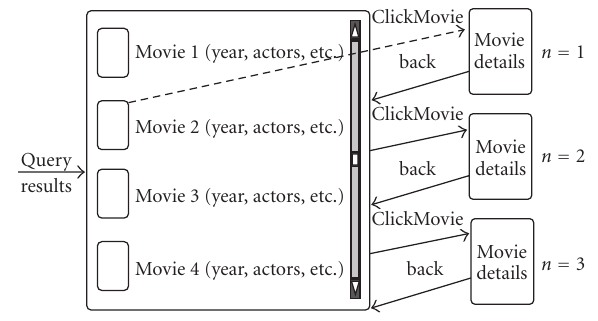
Figure 2: Information system of movie